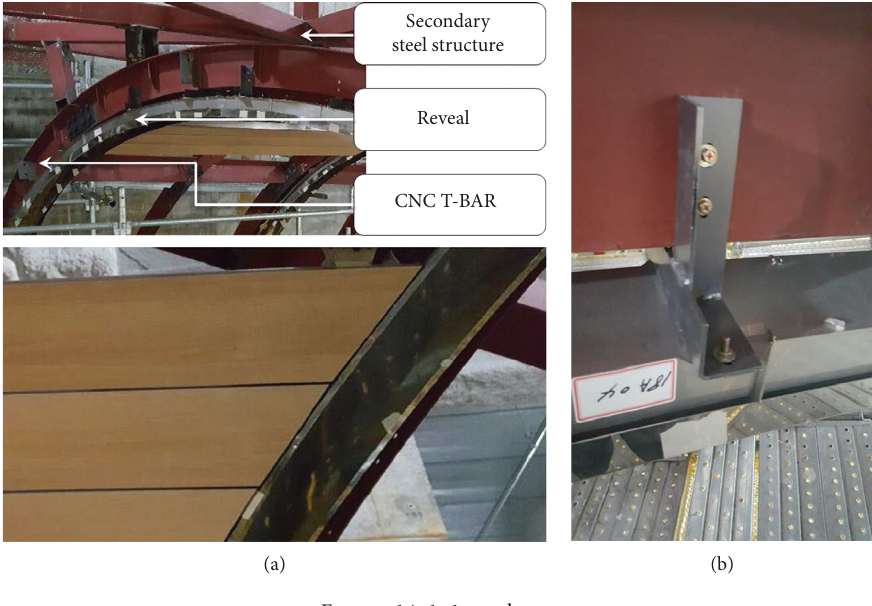
Figure 14: 1 :1 mock-up.